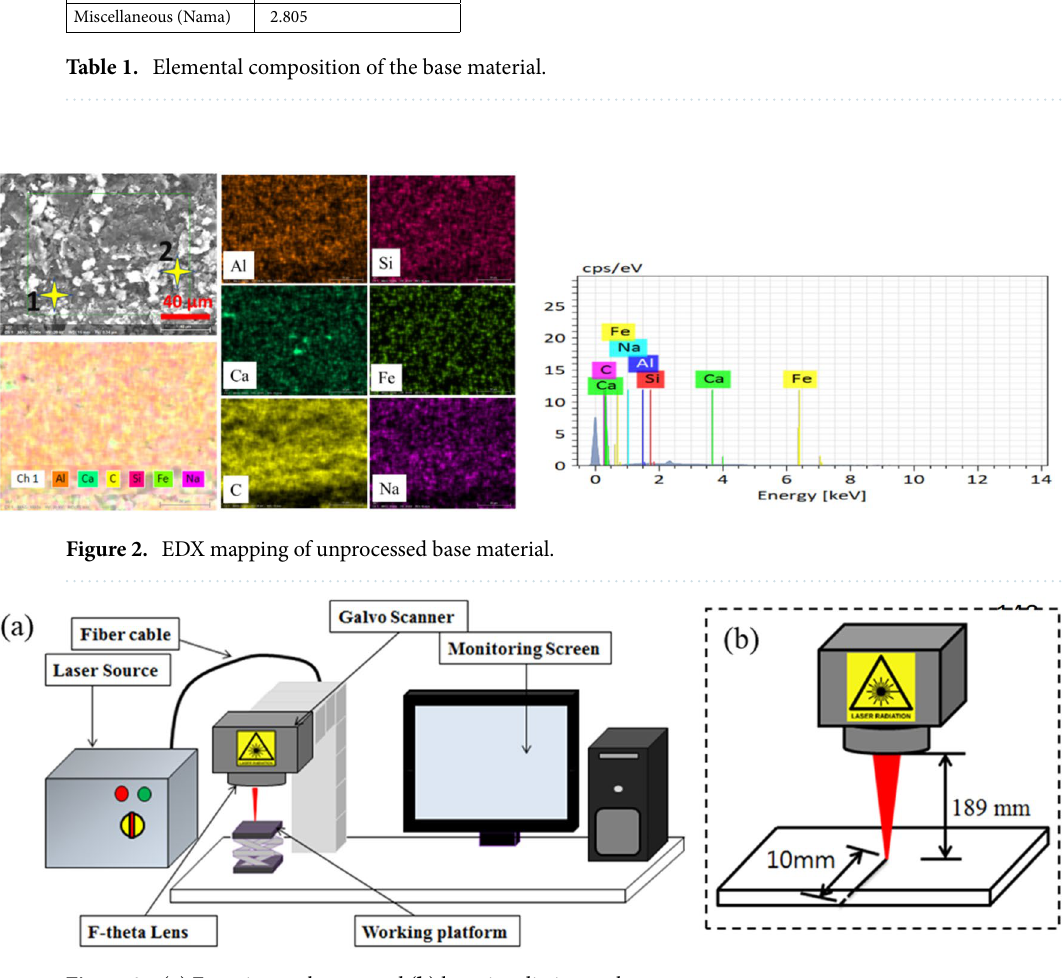
Figure 3. ( a ) Experimental setup and ( b ) laser irradiation